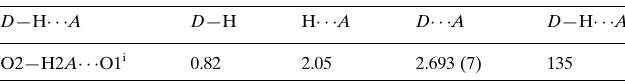
Hydrogen-bond geometry (A ˚ , (cid:3)